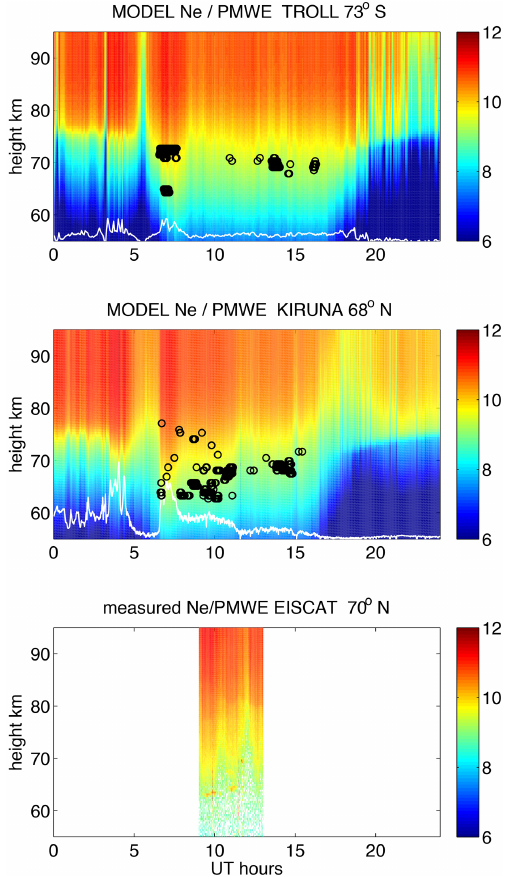
Figure 6. PMWE and CNA observations and modelled and ob- served electron densities on 21 March 2013. Top panel shows PMWE (black circles) and 54MHz CNA (white line) observations by the MARA radar in Antarctica, superimposed on modelled elec- tron densities (colour scale). Middle panel shows PWME (black cir- cles) observed by the ESRAD radar in Kiruna, Arctic Sweden, and 38MHz CNA (white line) observations from a riometer in Kiruna, superimposed on modelled electron densities. In the top two panels, 1dB CNA corresponds to 5km on the height axis. Bottom panel shows electron density/PMWE measurements by the EISCAT VHF radar, 200km north of Kiruna. The narrow yellow/red layer close to 10:00UT/65km is PMWE; elsewhere the colour scale shows elec- tron density (scale for electron densities is log 10 m − 3